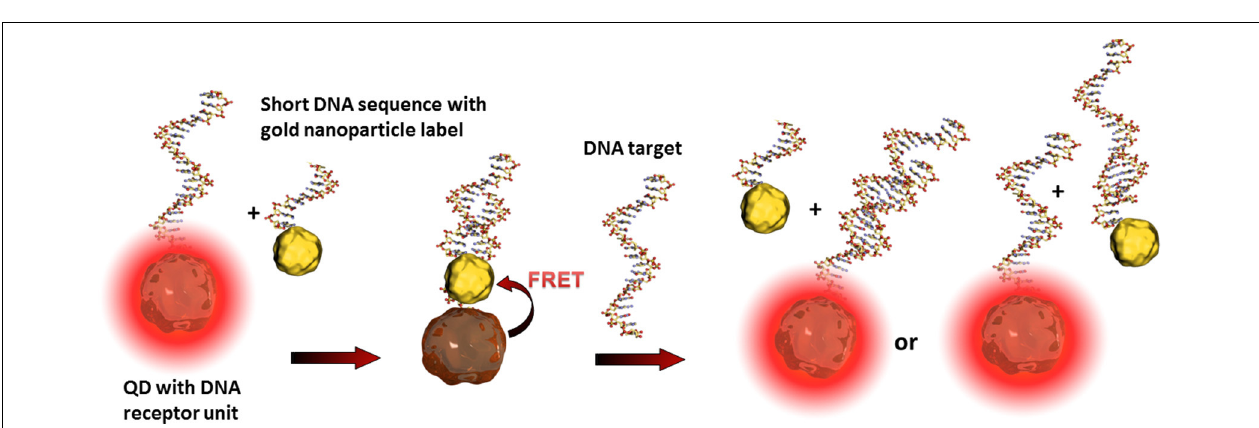
FIGURE 4 | Illustration of the FRET principle between QDs and gold nanoparticles and the reestablishing of fluorescence after the recognition event. The target DNA can hybridize either with the receptor